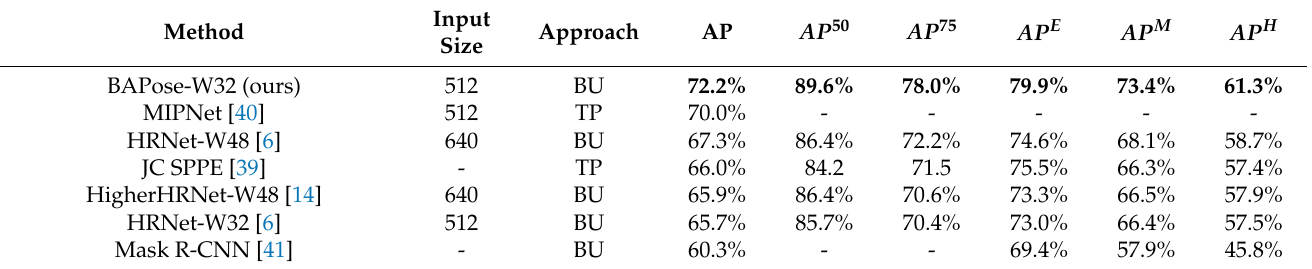
Figure 4. Pose estimation examples using BAPose with the CrowdPose dataset. Table 1. BAPose results and comparison with SOTA methods for the CrowdPose dataset for testing. TP and BU represent the top-down and bottom-up approaches, respectively. Best results are in